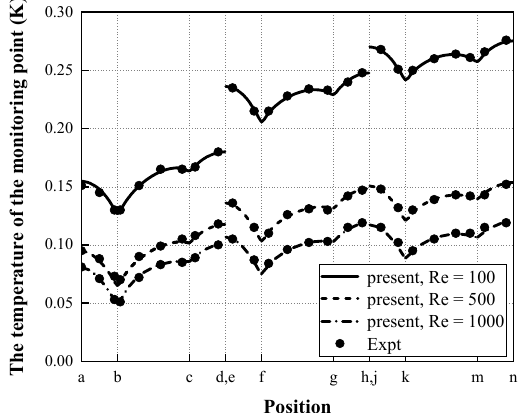
Figure 4. Comparison of the simulation results of the temperature at different monitoring points along the solid–fluid interface for rectangular blocks at Re = 100, 500, 1000 with the experimental data of Ref. [33].